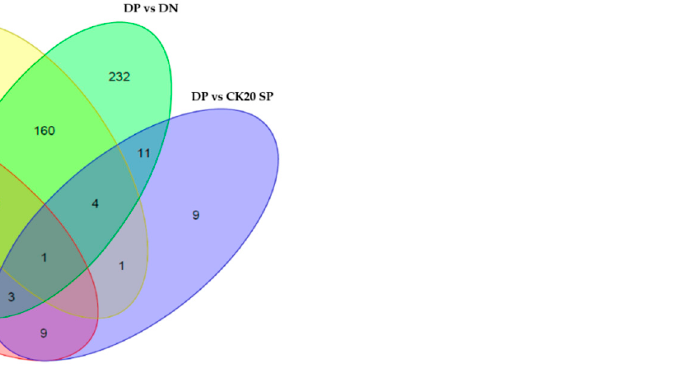
Figure 2. Venn diagram of differential expression genes (DEGs) in four major comparison conditions.